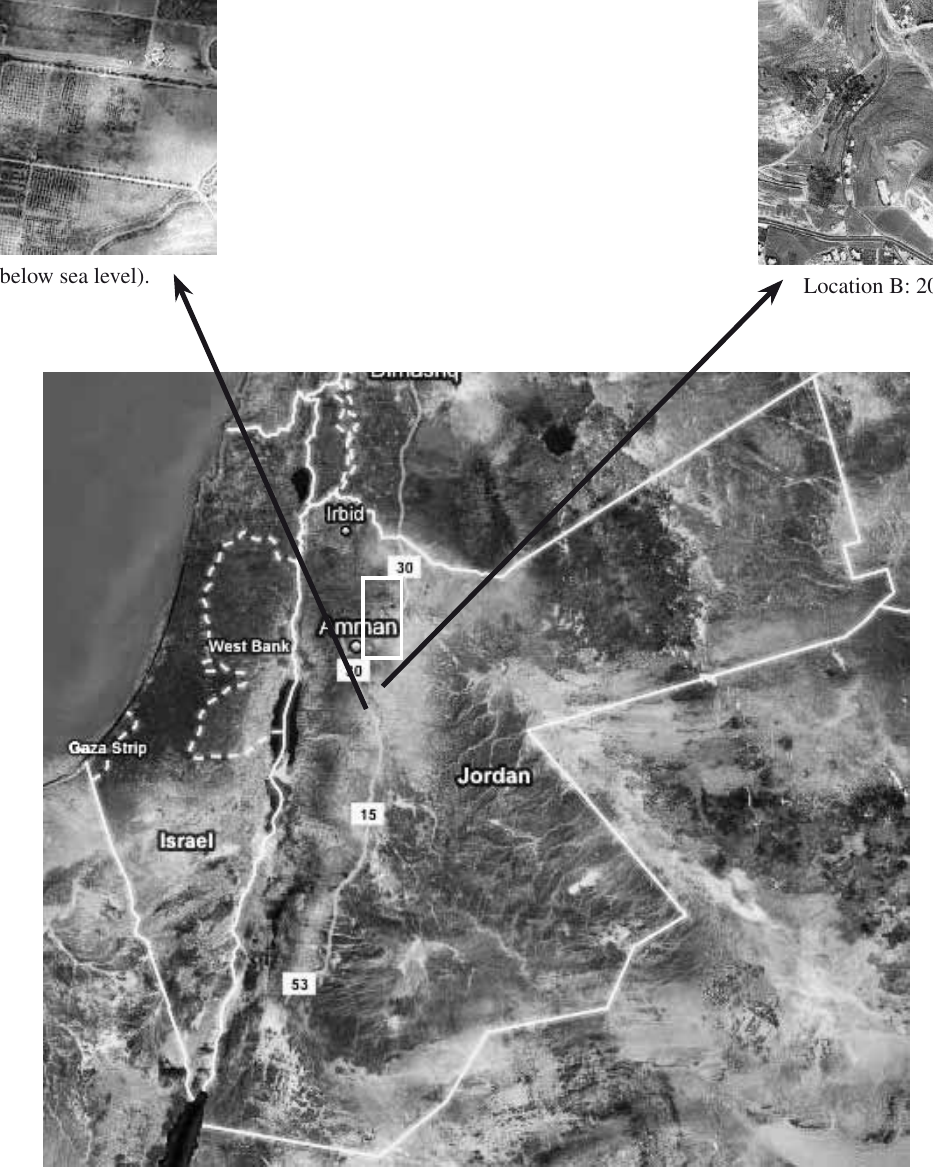
Fig. 2 - Research sites (53, 15, 30, 30, are the Main International Highway).